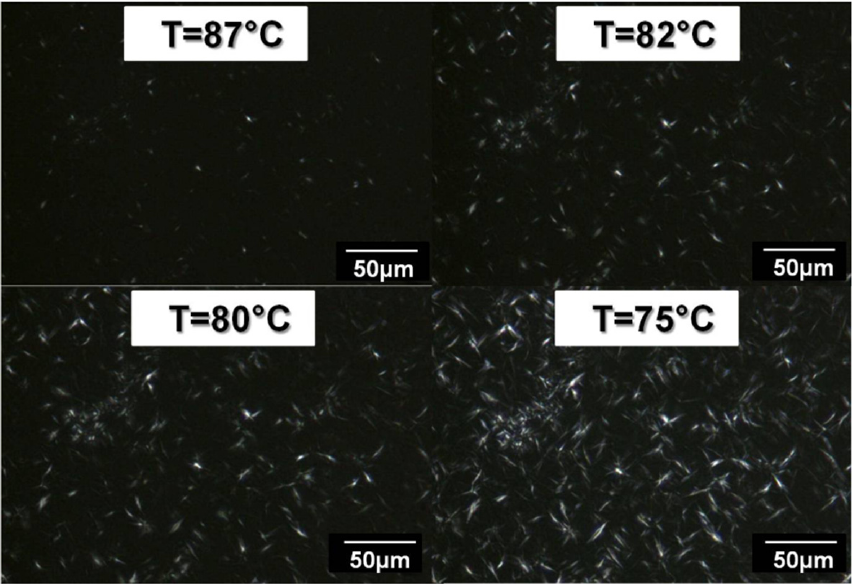
Figure 18. PE lamella crystallization for PE-b-PEG B (55 wt. % PEG) during a cooling ramp observed by optical microscopy in combination with polarized light.